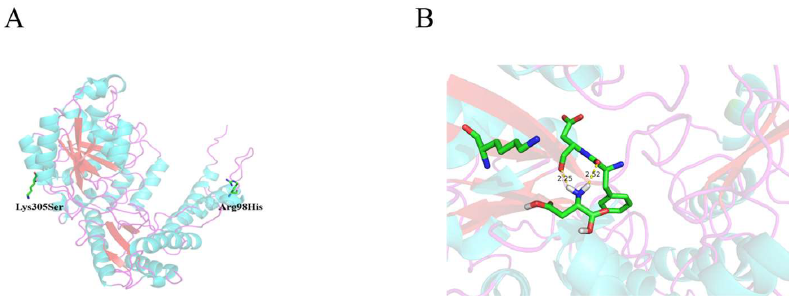
Figure 1. Three-dimensional structure of TcPanD ( A ) and Auto docking with L -Asp ( B ).